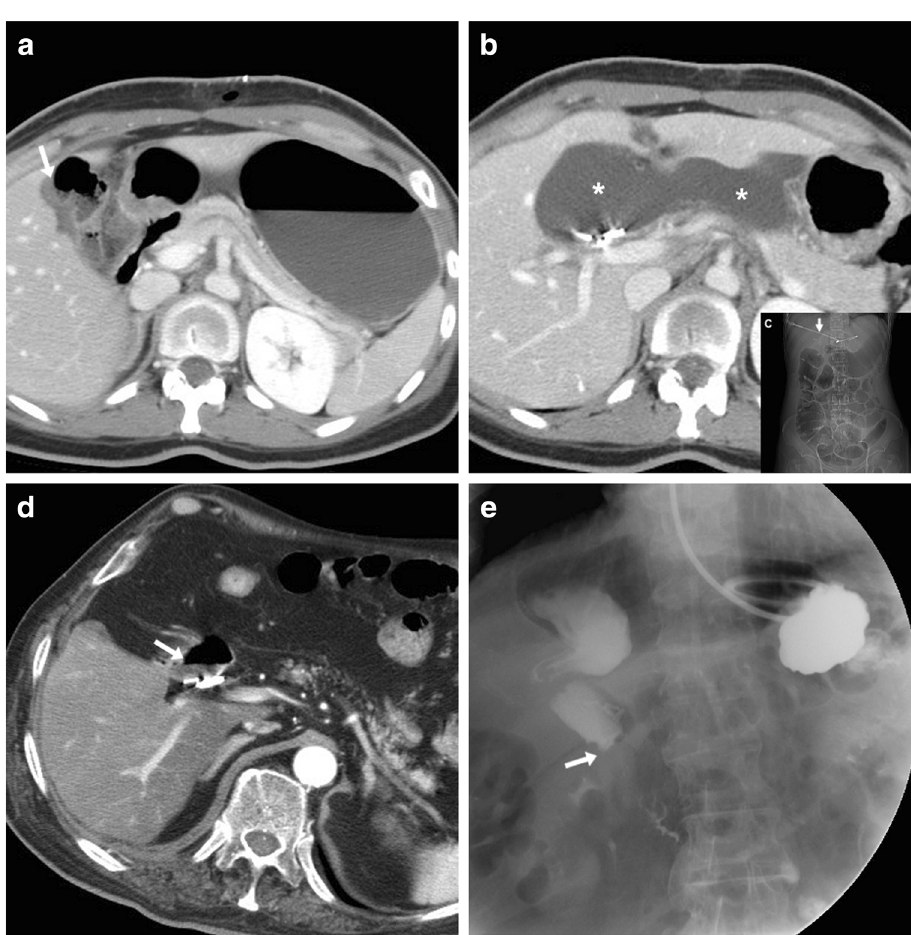
Fig. 7 a – c Early postoperative CT after laparoscopic cholecystectomy showed gastric dilatation with stagnant fluid, minimal fluid in the gallbladder fossa ( arrow in a ) and a homogeneous water-attenuation collection (* in b ) extending from the clips at the surgical site to- wards the lesser sac, consistent with biloma. Inset image c shows persistent gastrointestinal gaseous distension consistent with post- operative ileus, after percutaneous drainage ( thick arrow ) of biloma.